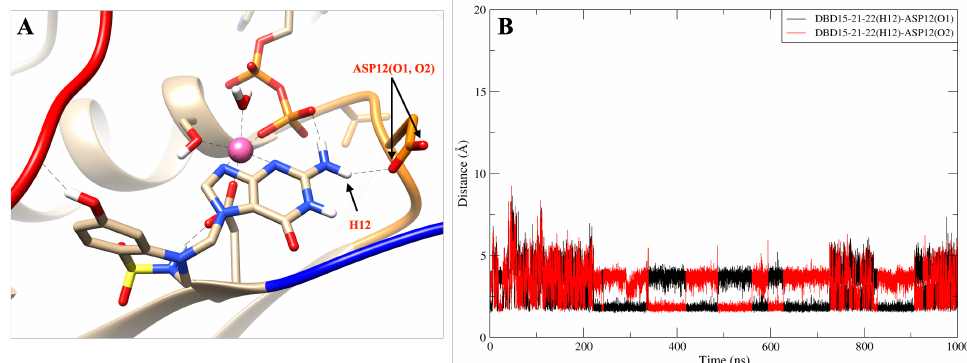
Figure A13. The hydrogen bond interaction between DBD15-21-22 (H12) and ASP12 (O1, O2). ( A ) Representative snapshot of HB DBD 15 − 21 − 22 ( H 12 ) − ASP 12 ( O 1/ O 2 ) ; ( B ) distance between DBD15-21- 22 (H12) and ASP12 (O1, O2).